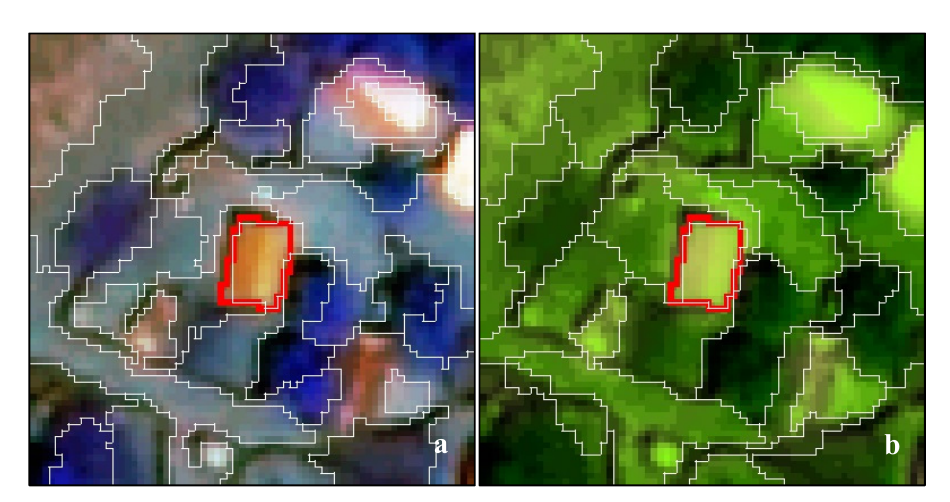
Figure 12. Example of best segmentation results achieved on ( a ) the original image and ( b ) an image transformed with the Transformation Matrix for the Hagadera site using the MS segmentation algorithm and RBSB metric.